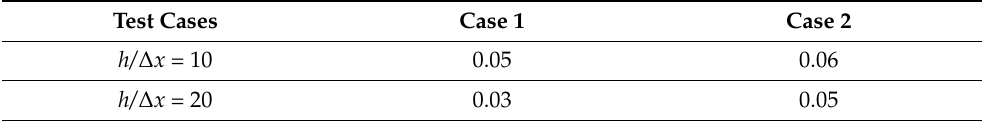
Figure 6. Velocity fields of case 2. Table 1. L 2 errors between the numerical and analytical